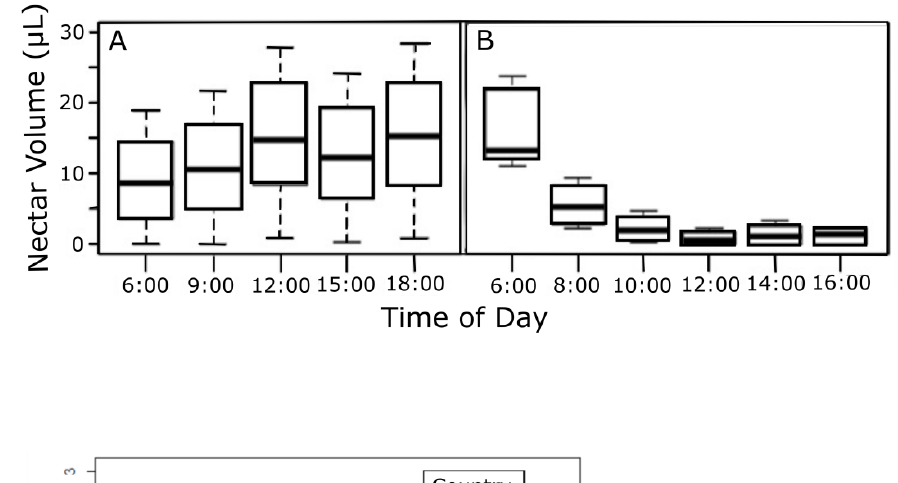
F IGURE 4. A comparison of hummingbird pollinator community of Oreocallis grandiflora in Ecuador (N = 175 hrs) versus Peru (N = 294